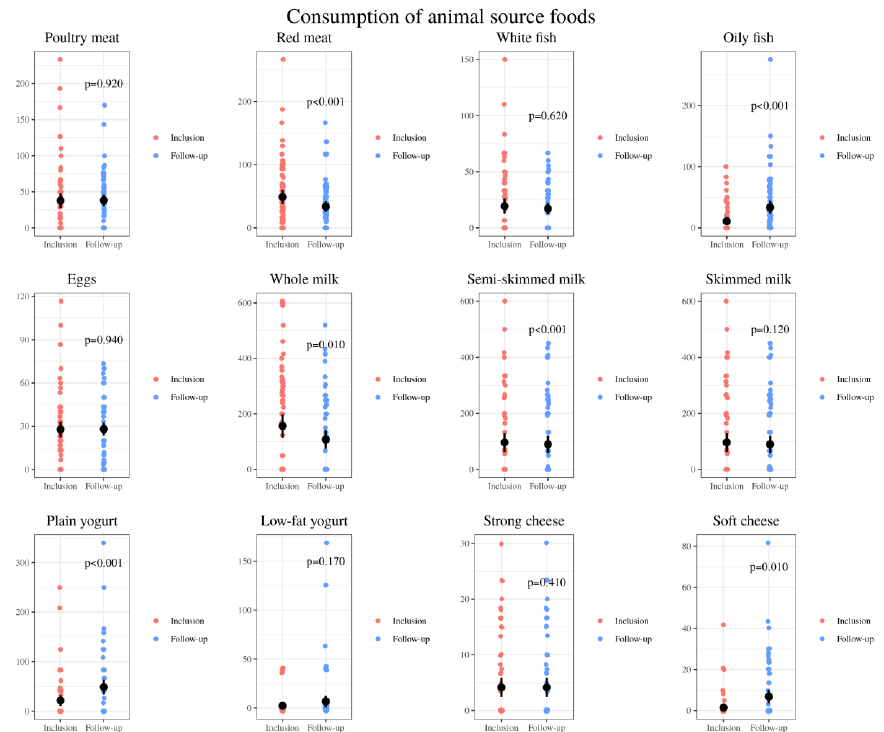
Figure 4. Comparison of the relative intake of animal-based whole foods: grams of poultry meat, red meat, white fish, oily fish, eggs, whole milk, semi-skimmed milk, skimmed milk, plain yogurt, low-fat yogurt, strong cheese, soft cheese per day consumed by 72 CD pediatric individuals at baseline (inclusion) and after nutrition intervention (follow-up). A clear decrease was observed in the intake of all ultra-processed products, high- lighting processed meats such as cold cuts, sweetened yogurts and other sugary dairy desserts, cookies and other types of pastries (Figure 5).